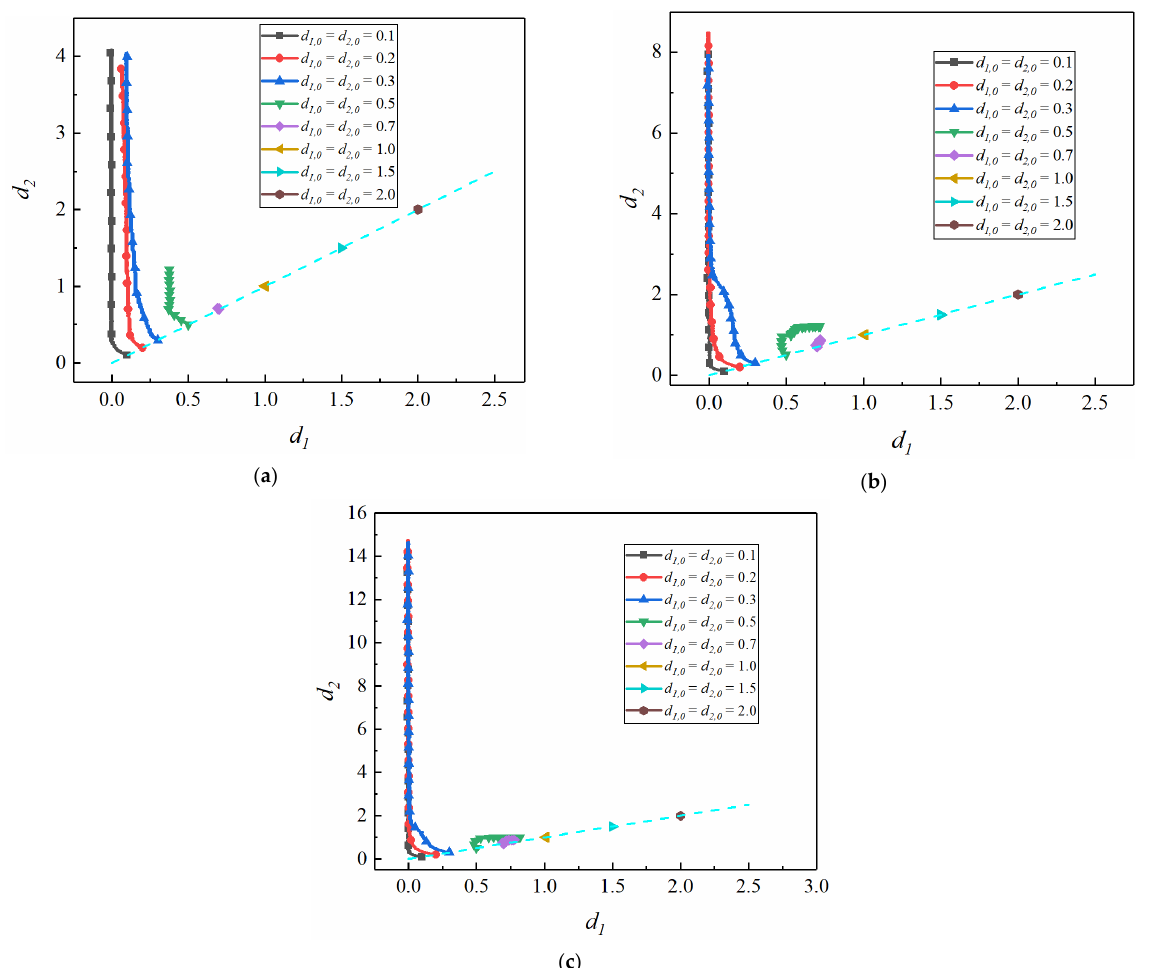
Figure 11. Diverse variations of interparticle distances for different initial confinement ratios ( Wi = 0.5, η r = 0.3, α = 0.1, y 0 = 0). ( a ) ε = 0.2; ( b ) ε = 0.3; ( c ) ε = 0.4.